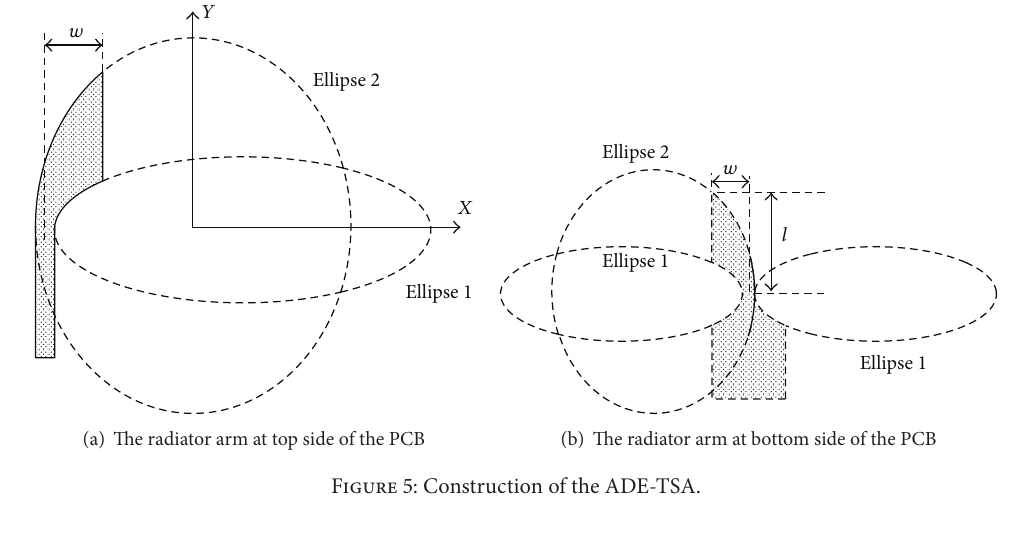
Figure 5: Construction of the ADE-TSA.